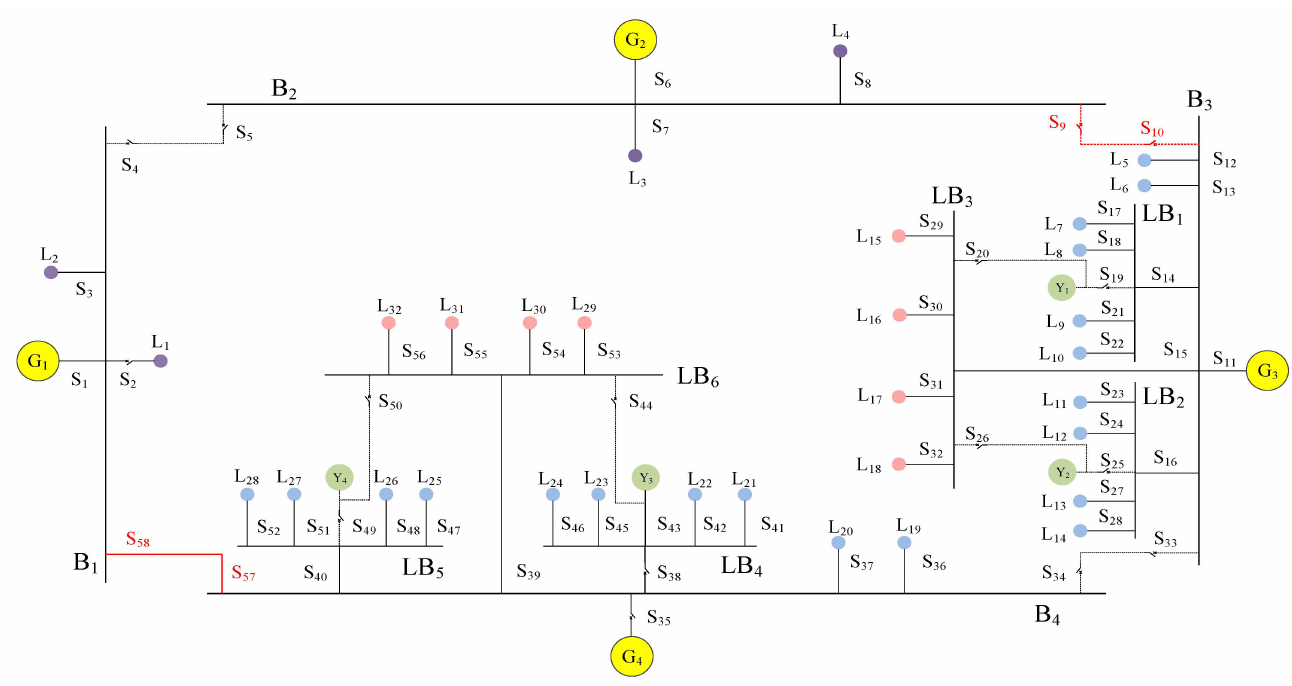
Figure 12. The revised system topology under fault scenario